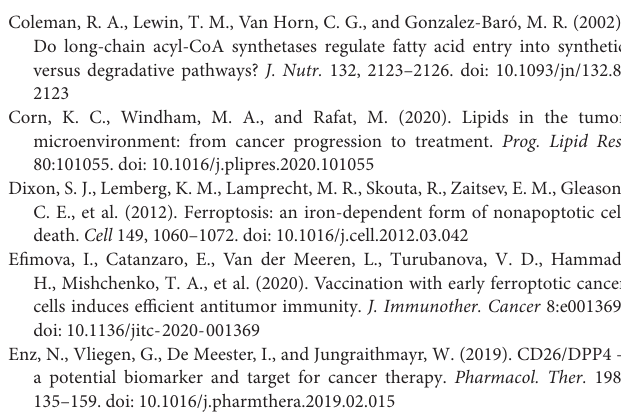
Supplementary Figure 1 | Multivariable Cox regression analysis to construct a prognostic risk score model. Supplementary Figure 2 | K-M survival analysis and ROC curves of risk prognostic model in internal and external validation. (A–C) K-M survival analysis of risk prognostic model of HNSCC patients in internal, entire, and external validated cohorts. (D–L) ROC curves analysis of risk prognostic model of HNSCC patients at 1, 3, and 5 years in internal, entire, and external validated cohorts. Supplementary Figure 3 | Representative results of GO and KEGG analyses. (A) The GO analysis of the 10 screened genes. (B) The potential signaling pathway of the 10 screened genes. Supplementary Figure 4 | Independent prognostic parameter identification in HNSCC patients. (A) The univariate Cox regression analysis of clinical parameters in HNSCC patients. (B) The multivariate Cox regression analysis of clinical parameters in HNSCC patients. Supplementary Figure 5 | The validation of nomogram in internal and external cohorts. (A–C) ROC curves to assess nomogram accuracy to predict 1-, 3-, and 5-year OS in internal cohort. (D–F) ROC curves to assess nomogram accuracy to predict 1-, 3-, and 5-year OS in entire cohort. (G–I) ROC curves to assess nomogram accuracy to predict 1-, 3-, and 5-year OS in external cohort. Supplementary Figure 6 | The analysis between risk score and different clinical parameters in HNSCC patients. (A) The difference of risk score is significant in HNSCC patients with different stage. (B) The difference of risk score is significant in HNSCC patients with different N stage. (C) The difference of risk score is significant in HNSCC patients with different lymphovascular invasion. (D) The difference of risk score is significant in HNSCC patients with different perineural invasion. Supplementary Figure 7 | The different immune infiltration in the high- and low-risk HNSCC patients. (A,B) The expression of eight immune cell types is higher in the low-risk group compared with that of the high-risk group. (C) The expression of four cell types is higher in the high-risk group compared with that of the low-risk group. Supplementary Figure 8 | The different immune checkpoint genes in the high- and low-risk HNSCC patients. (A,B) The expression of 10 immune checkpoint gene types is higher in the low-risk group compared with that of the high-risk group. (C) The expression of two immune checkpoint gene types is higher in the high-risk compared with that of the low-risk group. Supplementary Figure 9 | The correlations between the immune checkpoint genes and risk score. (A–J) The immune checkpoint genes were negatively correlated with the risk score in HNSCC patients. (K,L) The immune checkpoint genes were positively correlated with the risk score in HNSCC patients. Supplementary Table 1 | Univariate COX regression analysis of differentially expressed ferroptosis-related genes in HNSCC